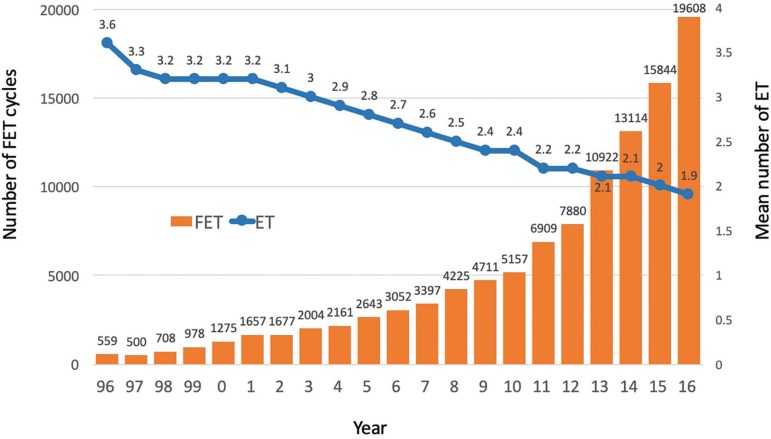
Number of FET cycles and mean number of embryo transferred according
to year. RLA, 1996 - 2016